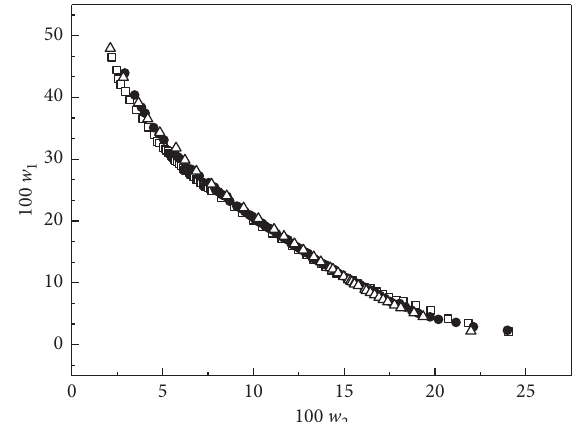
Figure 1: The binodal curves of the quaternary system polyethylene glycol+ ethanol+Na 2 SO 4 +water determined at T � 308.15, 318.15, and 328.15K; □ 308.15K; ● 318.15K; △ 328.15K.